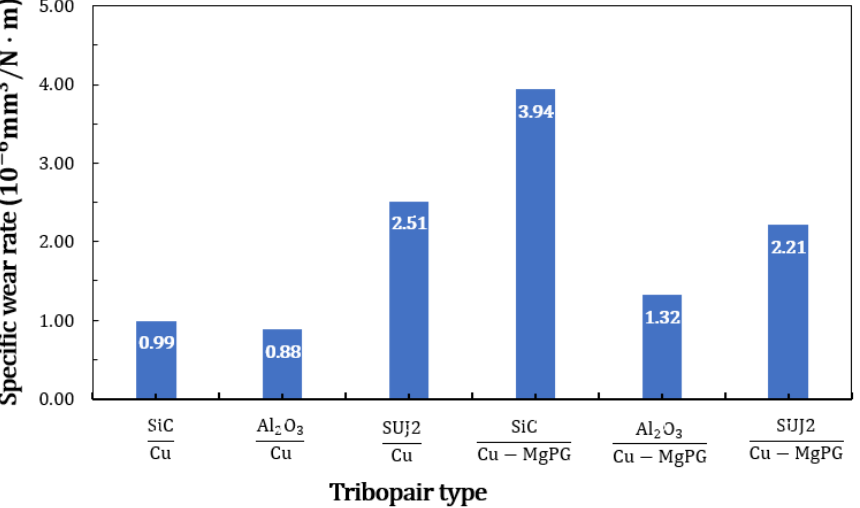
Figure 7. Average specific wear rates of SiC, Al 2 O 3 and SUJ2 counterbodies with different sintered disc.